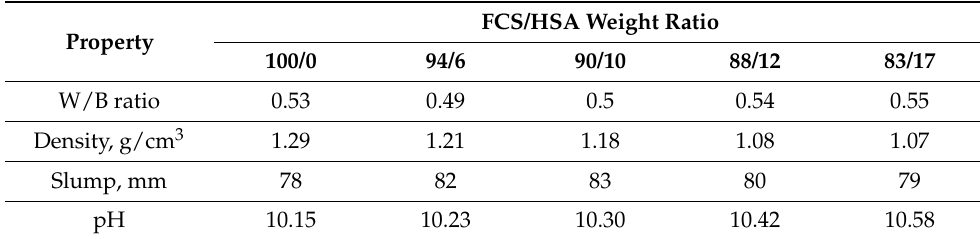
Table 2. Properties of CaP cement slurries with different FCS/HSA